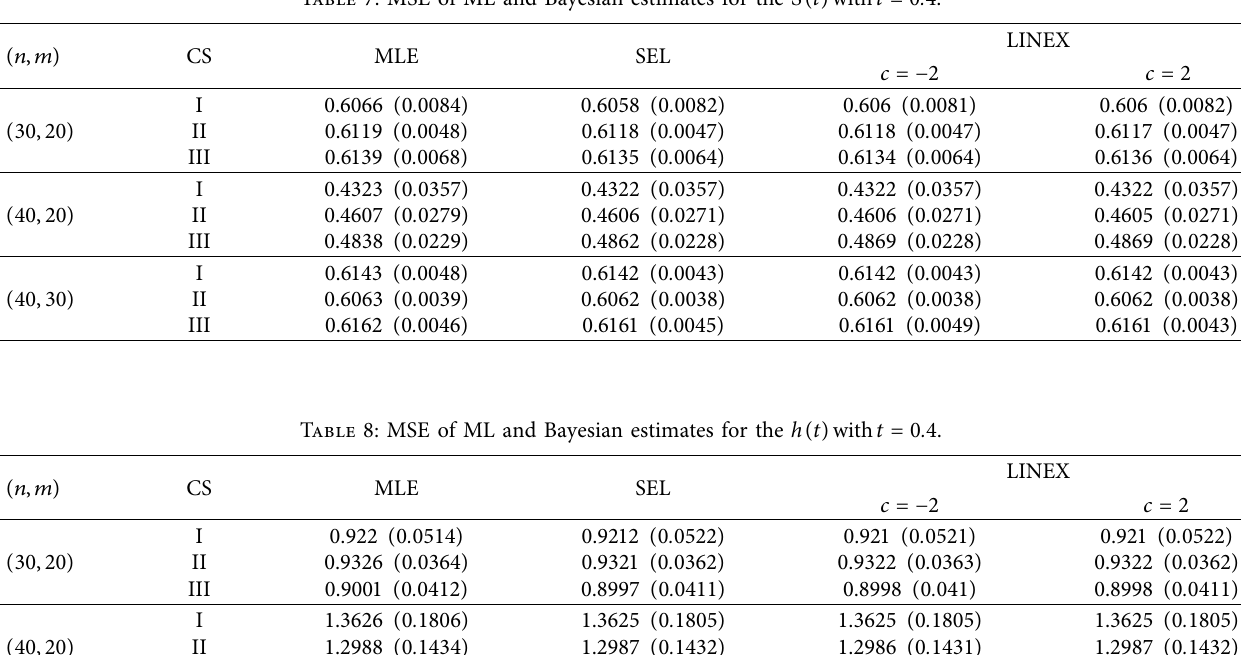
Table 6: MSE of ML and Bayesian estimates for the parameter λ with λ